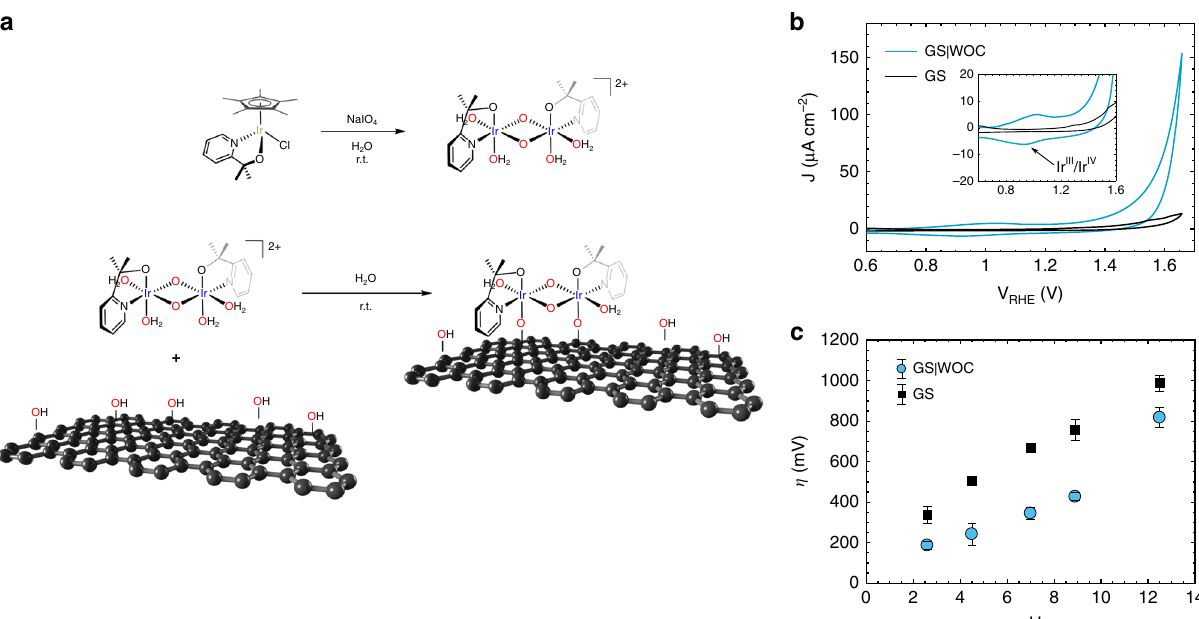
Fig. 5 Formation of the WOC and functionalisation of the GS surface. a Oxidative activation of the iridium precursor (top) and functionalisation of the GS surface (bottom). b Cyclic voltammetry (CV) scan of GS and GS functionalised with the Ir-WOC measured in 0.1 M KNO 3 at pH 2.6, with scan rate of 50 mV s − 1 . The inset shows a close-up of the potential axis, where the Ir III /Ir IV couple can be seen. c Electrode overpotentials at 10 μ A cm − 2 as a function of the pH of the solution. The error bars represent standard